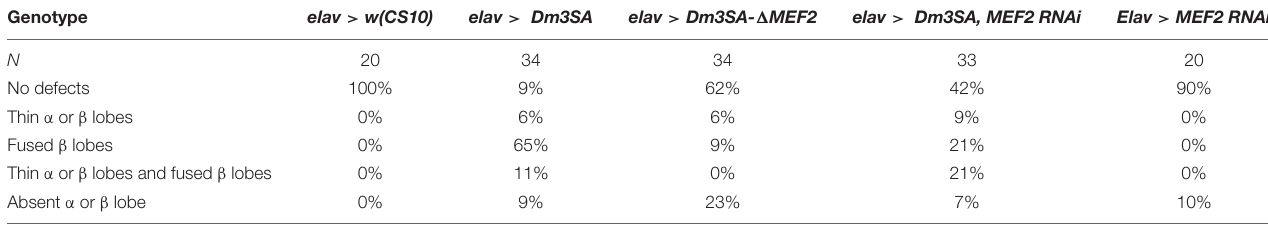
TABLE 2 | Frequency of mushroom body phenotypes resulting from expression of Dm3SA in the presence and absence of the MEF2 binding site. Genotype elav > w(CS10) elav >